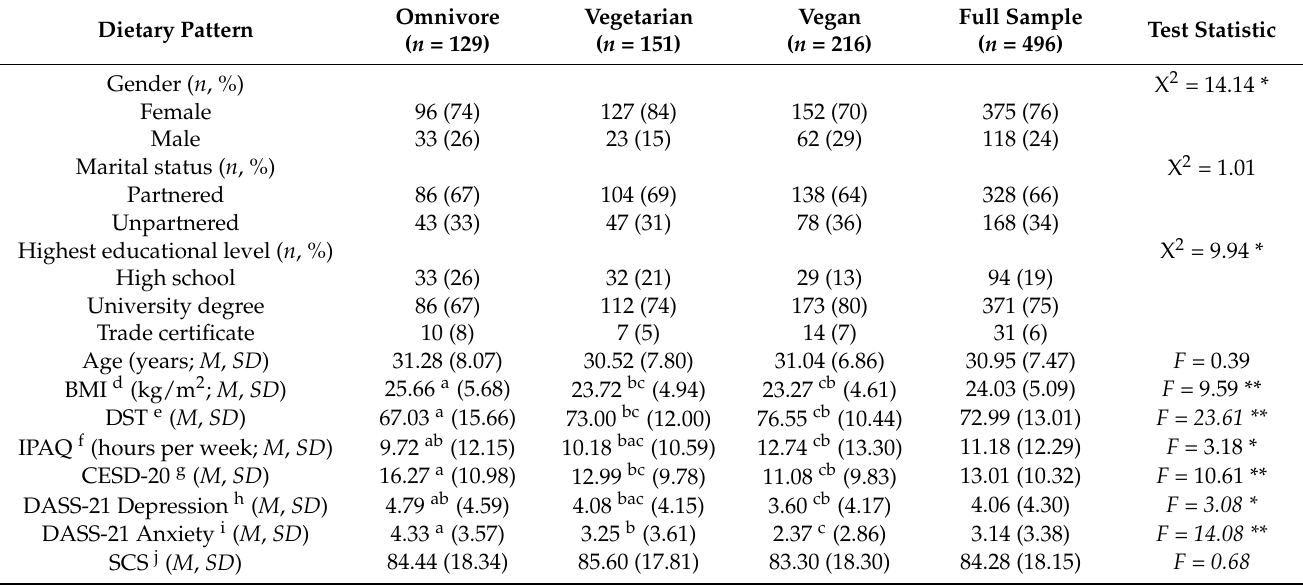
Table 1. Demographic and lifestyle statistics per dietary pattern.